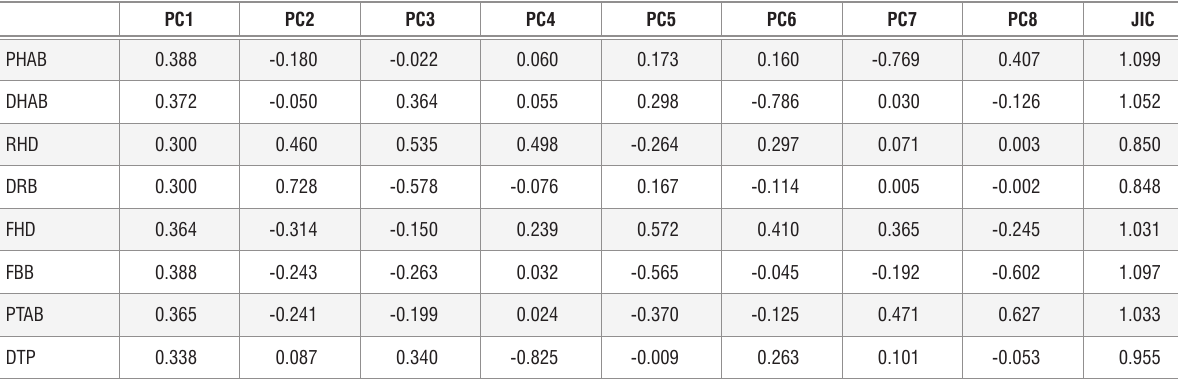
JIC, Jolicoeur multivariate allometry coefficients; PHAB, mediolateral diameter of the articular surface of the humeral head; DHAB, mediolateral diameter of the anterior surface of the distal humeral articular surface (trochlea + capitulum); RHD, maximum diameter of the radial head; DRB, maximum mediolateral diameter of the distal radial articulation; FHD, femoral head diameter (superoinferior or anteroposterior); FBB, maximum mediolateral diameter of the distal femur; PTAB, maximum mediolateral diameter of the tibial articular plateau; DTP, the square root of the product of the maximal mediolateral diameter (including the medial malleolus) and the maximum anteroposterior diameter of the distal